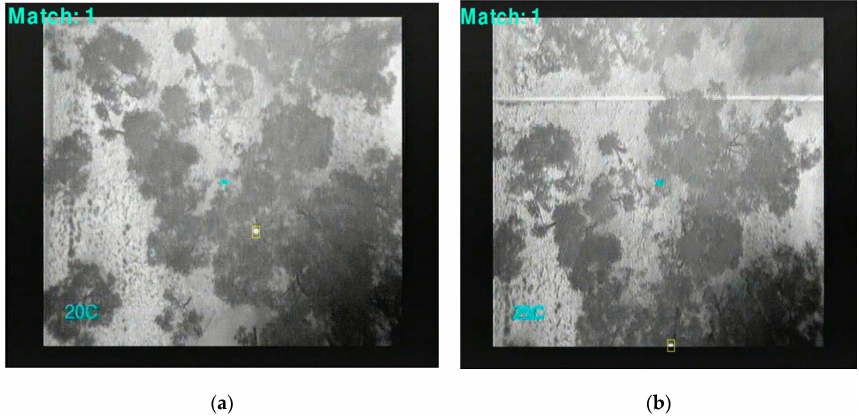
Figure 18. Koala tracking and detection above the canopy at 30 m.